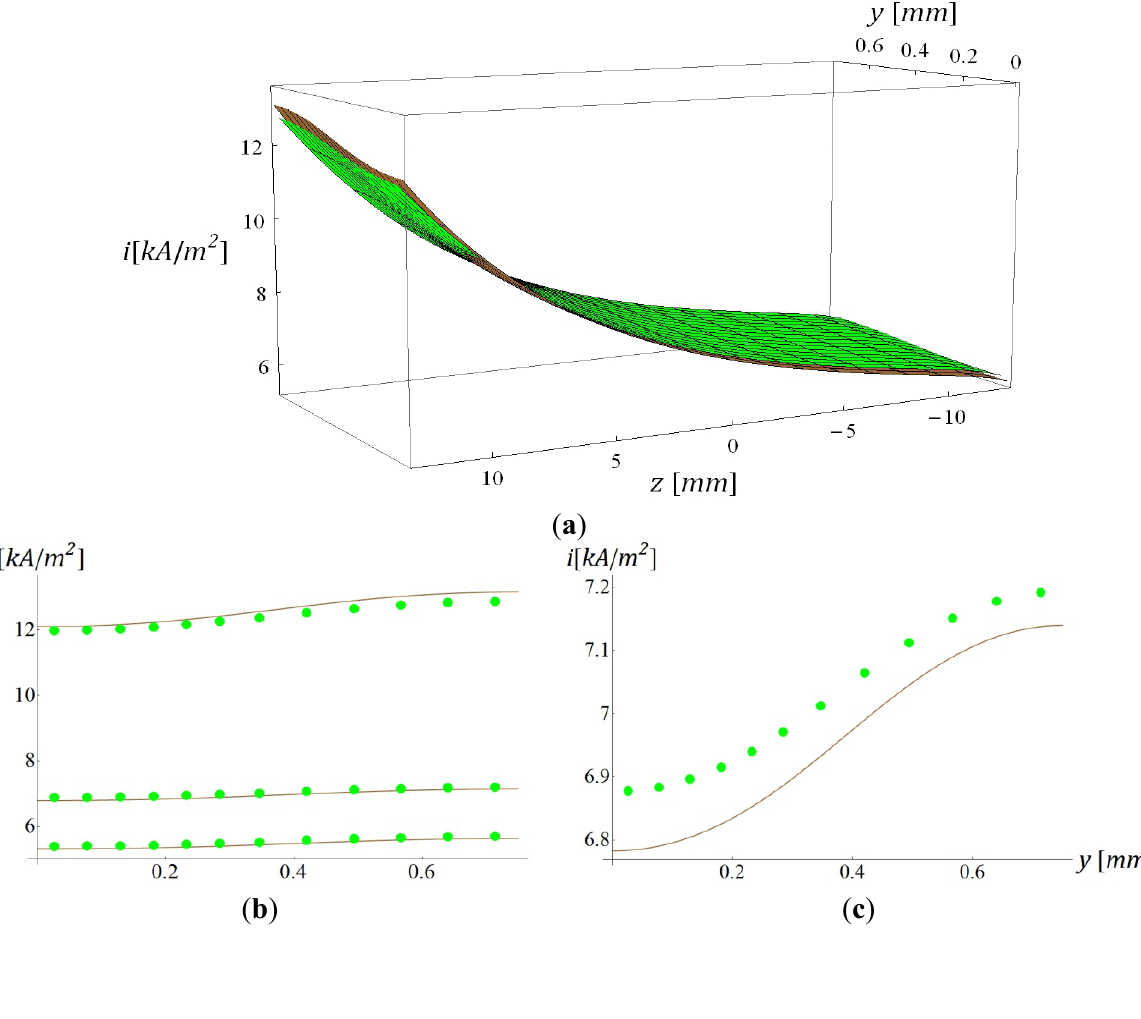
Figure 9. Current density distribution at the lowest operational voltage. Green are CFD results and brown HAN-FC results. ( a ) 3D plot of current density distribution over whole catalyst surface of the representative unit ( b ) 2D plot of current density distribution over the width of the representative unit at the inlet ( z = − 13.5 mm), midway ( z = 0 mm) and outlet ( z = 13.5 mm) represented by bottom, middle and top curves respectively; ( c ) Close-up 2D plot of current density distribution over the width of the representative unit midway between inlet and